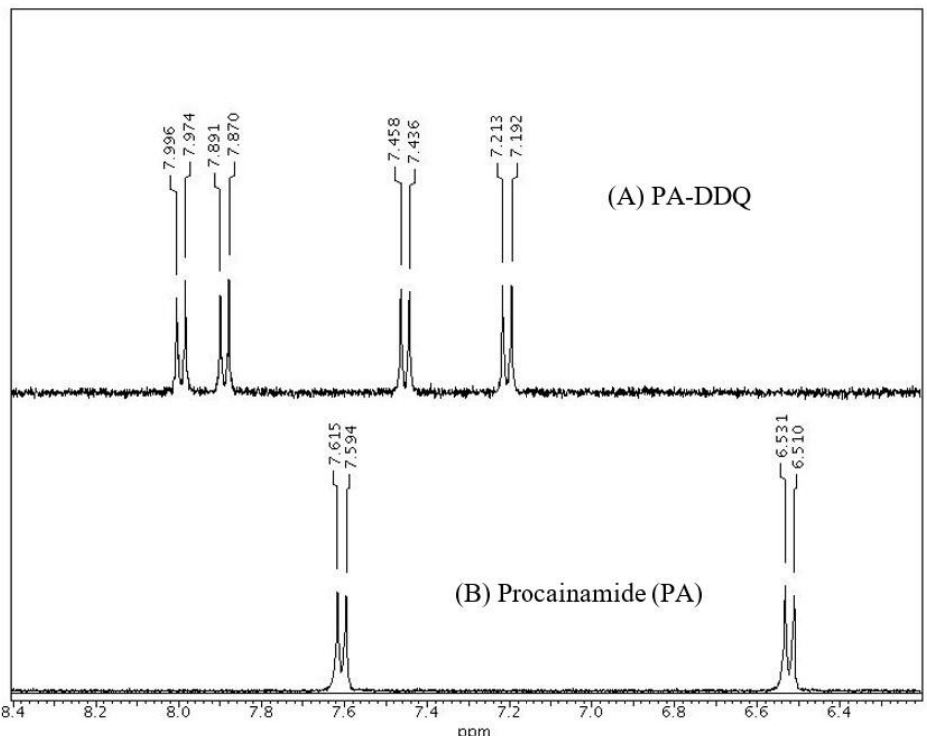
Figure 9. Comparison of proton-NMR ( 1 H-NMR) spectra of PA and PA-DDQ complex. ( A ) aromatic region of PA-DDQ complex; ( B ) aromatic region of PA.